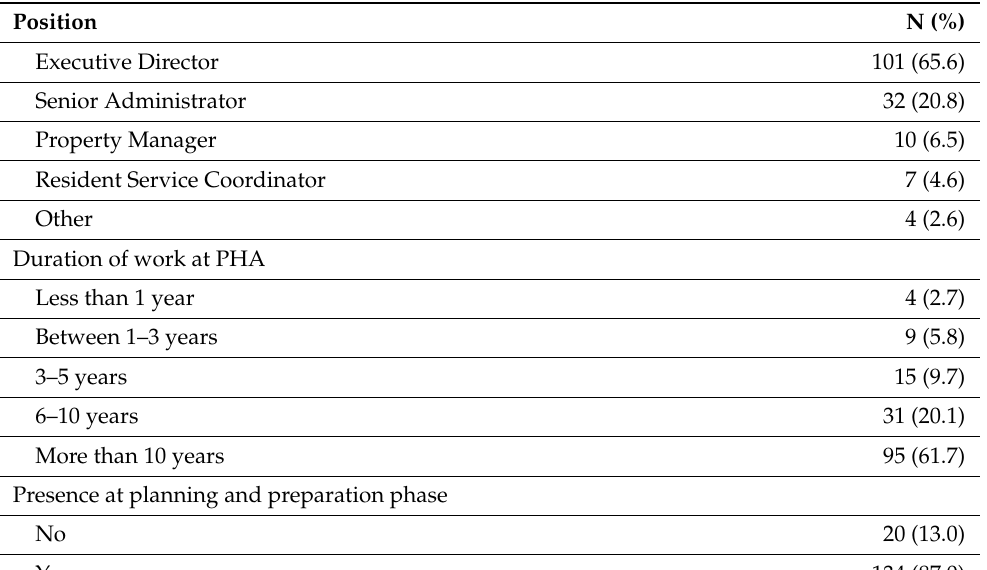
Table 1. Characteristics of PHA staff